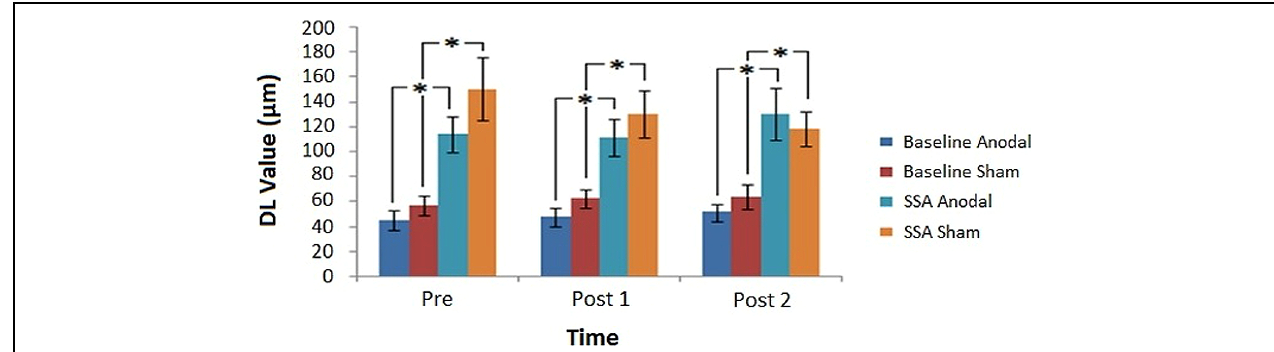
FIGURE 5 | Post-tDCS amplitude discrimination thresholds. Average DL values obtained before and after tDCS, for each task condition in relation to the assessed stimulation modes ( ∗ denotes significance, p < 0.05). Error bars represent ± 1 SEM.